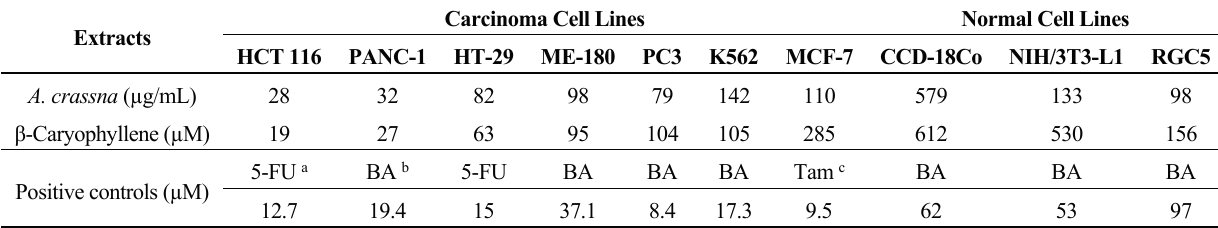
Table 3. IC 50 values of β -caryophyllene on various human cancer cell lines. Extracts